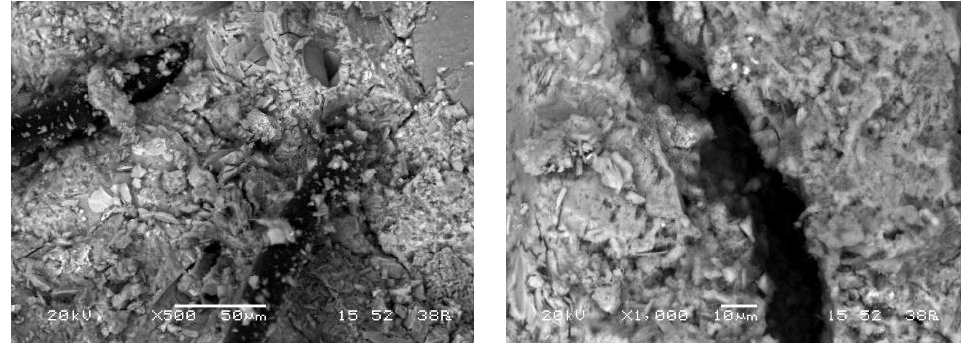
Figure 12. Microstructure SEM images of fiber reinforced concrete.